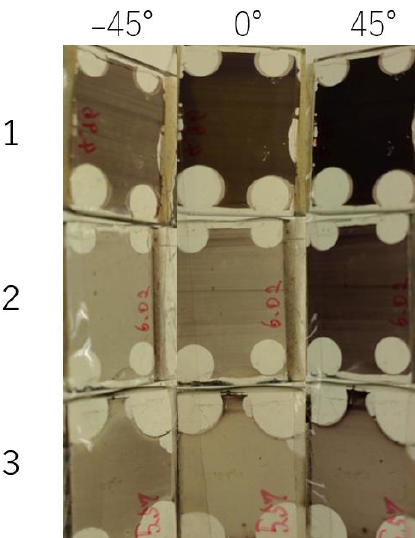
Figure 7. Photographs of GHLC cells with high pretilt angles, tilted by angles of −45°, 0°, and 45° about the vertical direction. The rows labeled 1, 2, and 3 in this figure correspond to cells with pretilt angles of 22°, 48°, and 44°, respectively.